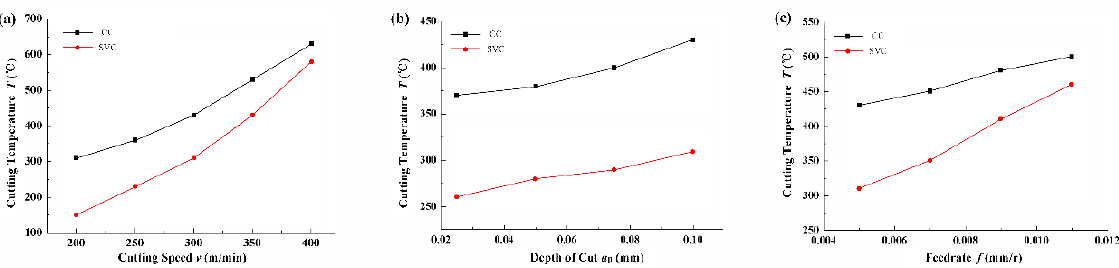
Figure 9. Cutting temperature vs. ( a ) cutting speed (feed rate, 0.005 mm / r; depth of cut, 0.1 mm), ( b ) depth of cut (cutting speed, 300 m / min; feed rate, 0.005 mm / r), and ( c ) feed rate (cutting speed, 300 m / min; depth of cut, 0.1 mm).